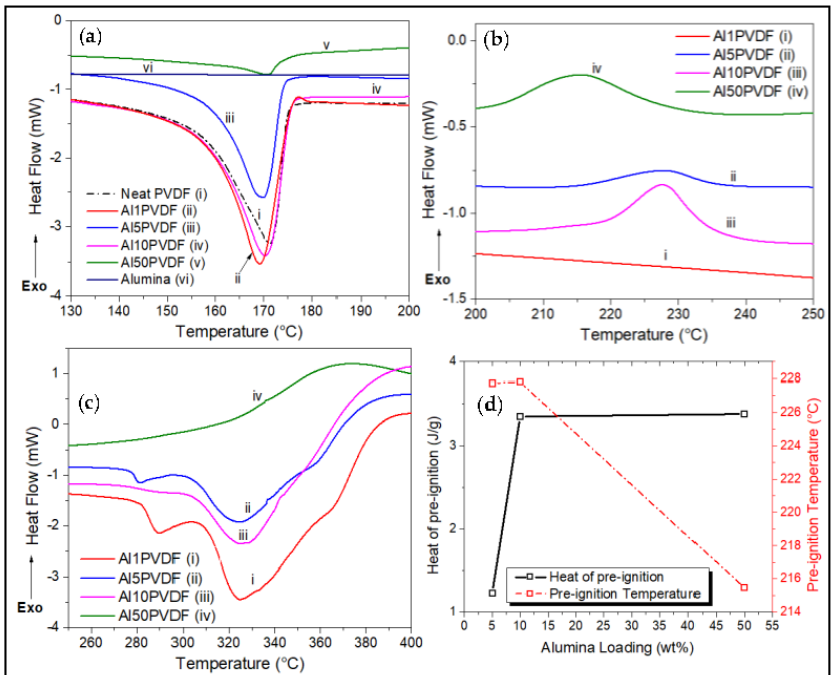
Figure 2. DSC thermograms of varying Alumina wt.% loadings on PVDF, showing ( a ) endothermic melting peaks, and pre-ignition exotherms between ( b ) 200 °C and 250 °C and between ( c ) 250 °C and 400 °C, carried out under N 2 atmosphere. ( d ) Degree of crystallization and melt peak temperature trend with loading.